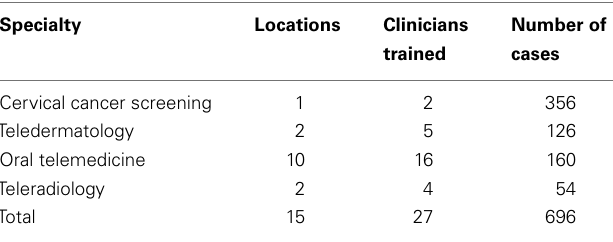
Table 1 | Number of locations, clinicians trained and mHealth cases (January 2011 to September 2013)